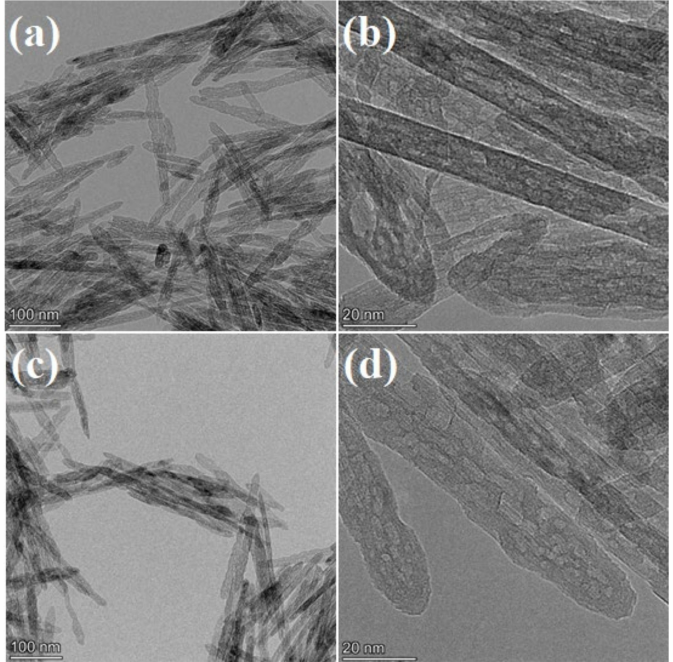
Figure 3. TEM images of ( a , b ) n-Al 2 O 3 and ( c , d ) 3% CuZnO/n-Al 2 O 3